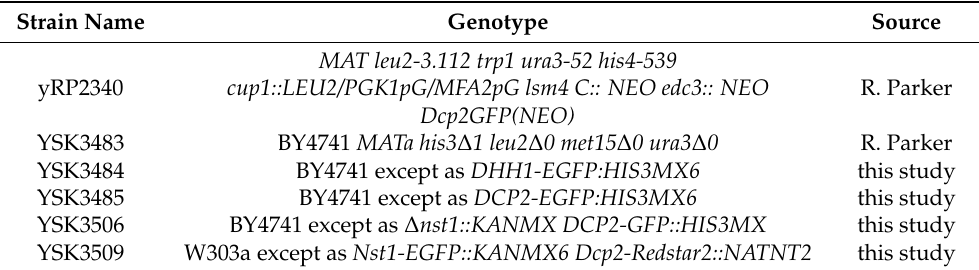
Table 1. List of the yeast strains used in this